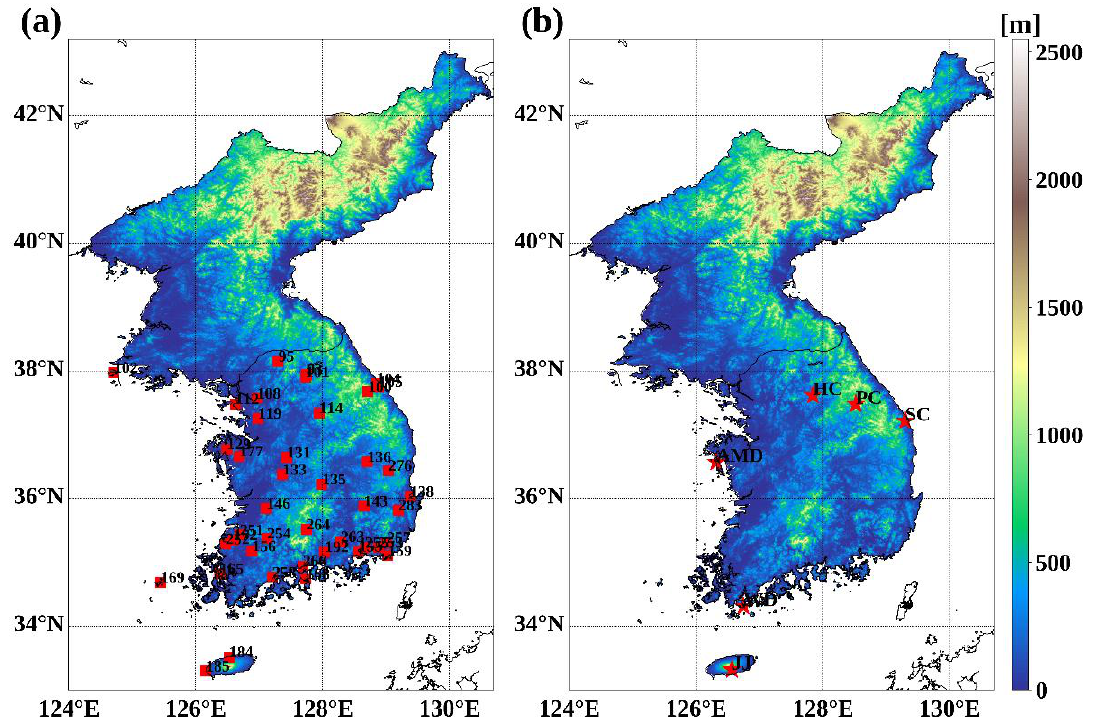
Figure 2. Distribution of the digital elevation model (DEM), where the red squares and stars indicate the ( a ) Automated Surface Observing System (ASOS) stations and ( b ) flux towers, respectively.